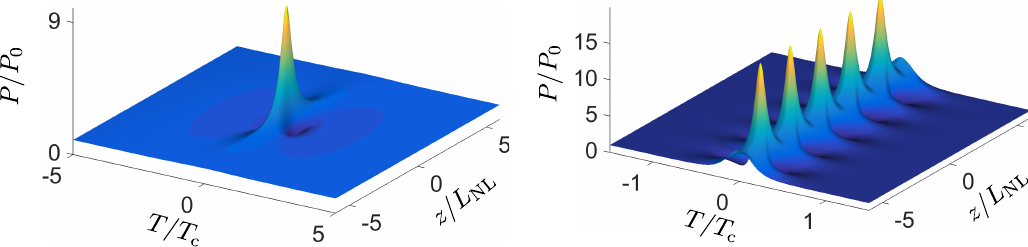
Figure 5. Evolution of a Peregrine soliton (left) and a Kuznetsov–Ma soliton (right). T c = 2 π / ω c